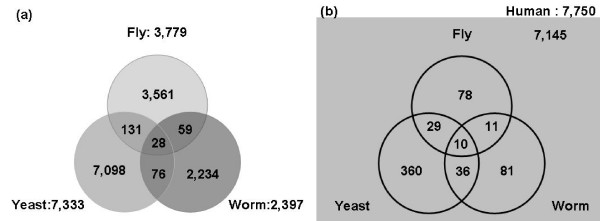
A Venn diagram for the numbers of predicted domain-domain interactions in yeast, worm, fruitfly, and humans. (a) The numbers of predicted domain-domain interactions in yeast, worm, and fruitfly. (b) The numbers of predicted domain-domain interactions between humans and the other three species.